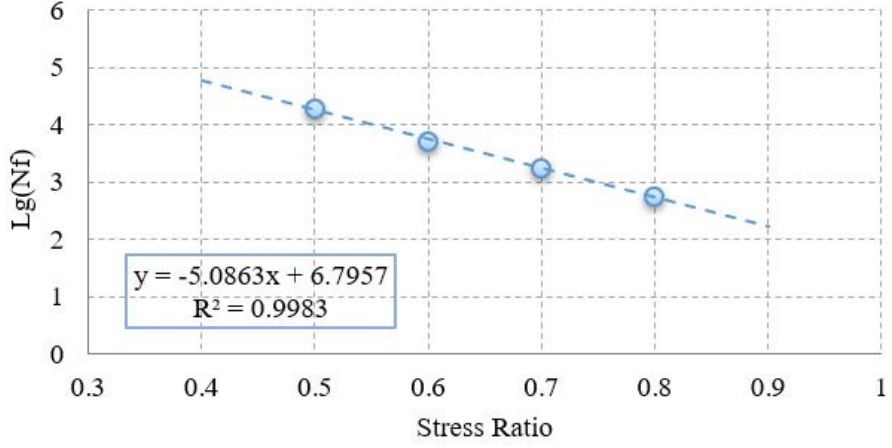
Figure 10. Logarithmic relationship between stress ratio and fatigue life.